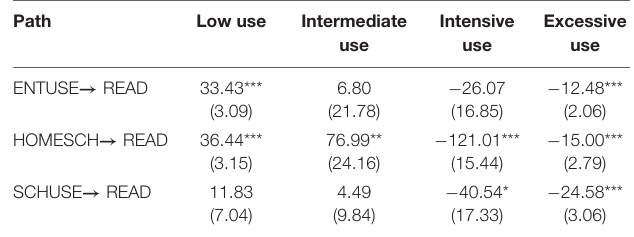
TABLE 5 | The moderation analysis of ICT use